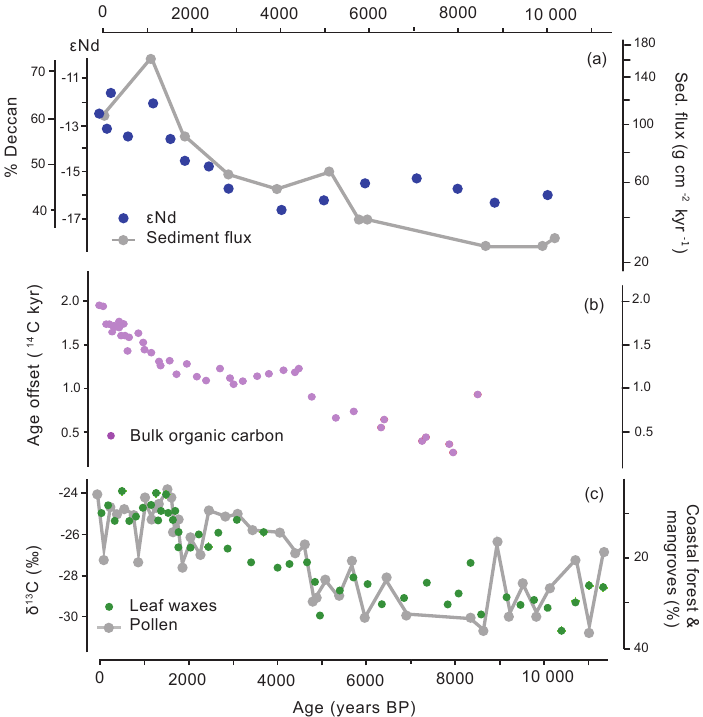
Figure 2. Paleoenvironmental reconstructions from core NGHP-01-16A for the Core Monsoon Zone as integrated by the Godavari River: (a) sediment fluxes as mass accumulation rates and sediment sources from Nd isotope fingerprinting (Deccan Trap sediment contribution is estimated from a two-end-member model; see text and Supplement); (b) TOC radiocarbon age offset relative to depositional age; (c) hydro- climate and ecology from pollen (Zorzi et al., 2015) and leaf-wax carbon isotopes (Ponton et al., 2012).